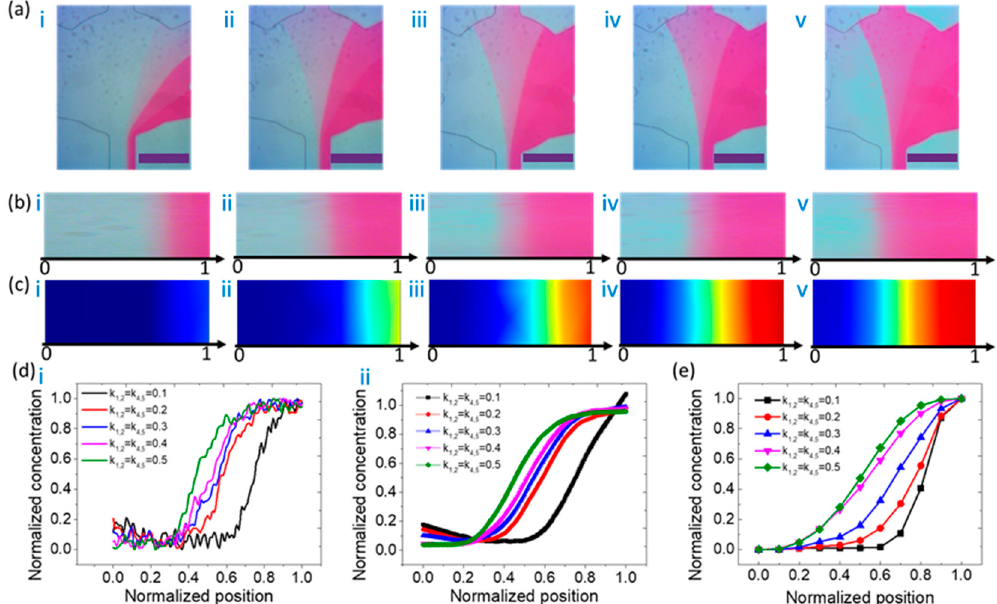
Figure 5. ( a ) Experimental results of the concentration distribution at the outlet of the microfluidic device. From left to right, i denotes the case of k 1,2 = k 4,5 = 0.1; ii denotes the case of k 1,2 = k 4,5 = 0.2; iii denotes the case of k 1,2 = k 4,5 = 0.3; iv denotes the case of k 1,2 = k 4,5 = 0.4; and v denotes the case of k 1,2 = k 4,5 = 0.5. The scale bar is 200 μ m. The concentration matrix is C = (0, 0, 0, 1, 1). ( b ) Partial enlarged view of the mass concentration of the outlet corresponding to (a). ( c ) Numerical simulation results of the concentration distribution at the outlet of the microfluidic device. From left to right, the flow ratios are shown in the cases of i to v. ( d ) Experimental results of normalized concentration as a function of normalized position at the outlet of the microfluidic device, whose pattern is like an S-type curve. A smoothing process technique was adopted from i to ii. ( e ) Numerical simulation results of normalized concentration as a function of normalized position at the outlet of the microfluidic device.